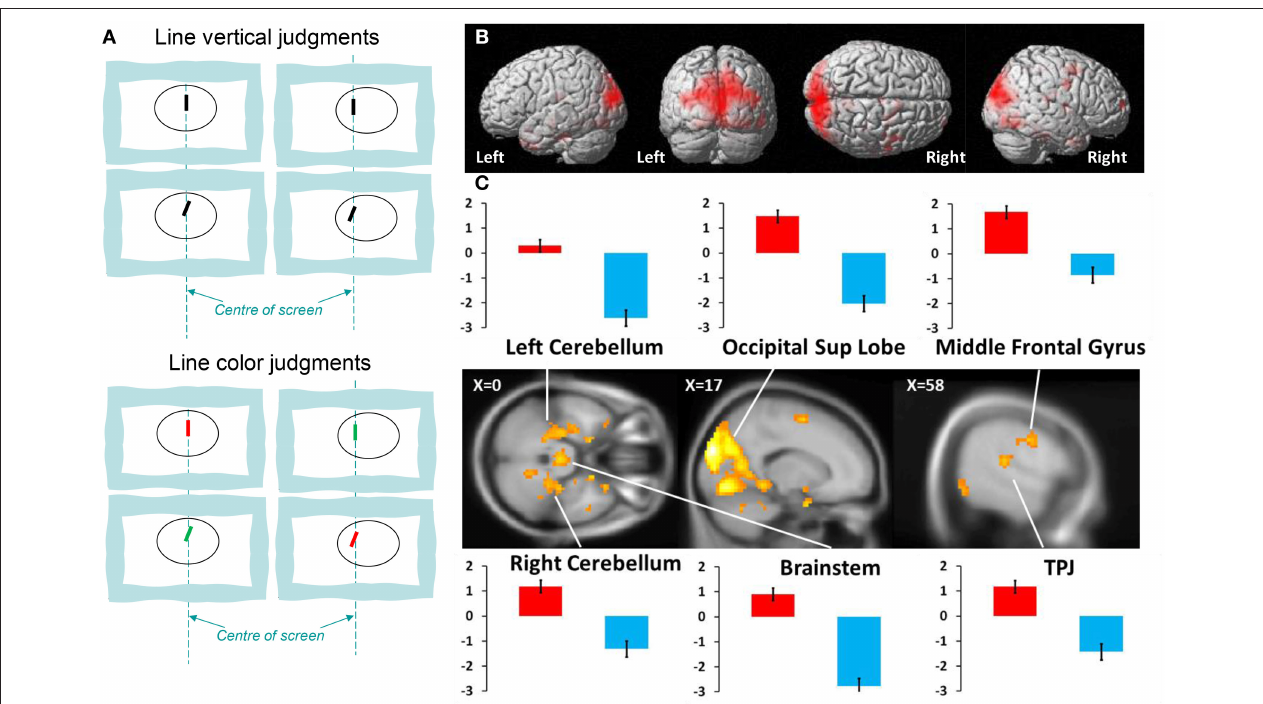
FIGURE 1 | (A) Examples of stimuli for Line Verticality (LV) judgment and Line Color (LC) judgment; (B) activation in the whole group ( n = 16) during LV vs. LC control tasks ( P < 0.001 uncorrected; cluster size > 10); (C) fMRI analyses for vertical task. Activated brain regions are projected on a standard anatomical template. Parameter estimates of activity (beta value, in arbitrary units, averaged across responsive voxels in each cluster) are shown for main peaks in each task condition. Red bars, vertical task; blue bars, control task; TPJ, temporo-parietal junction.